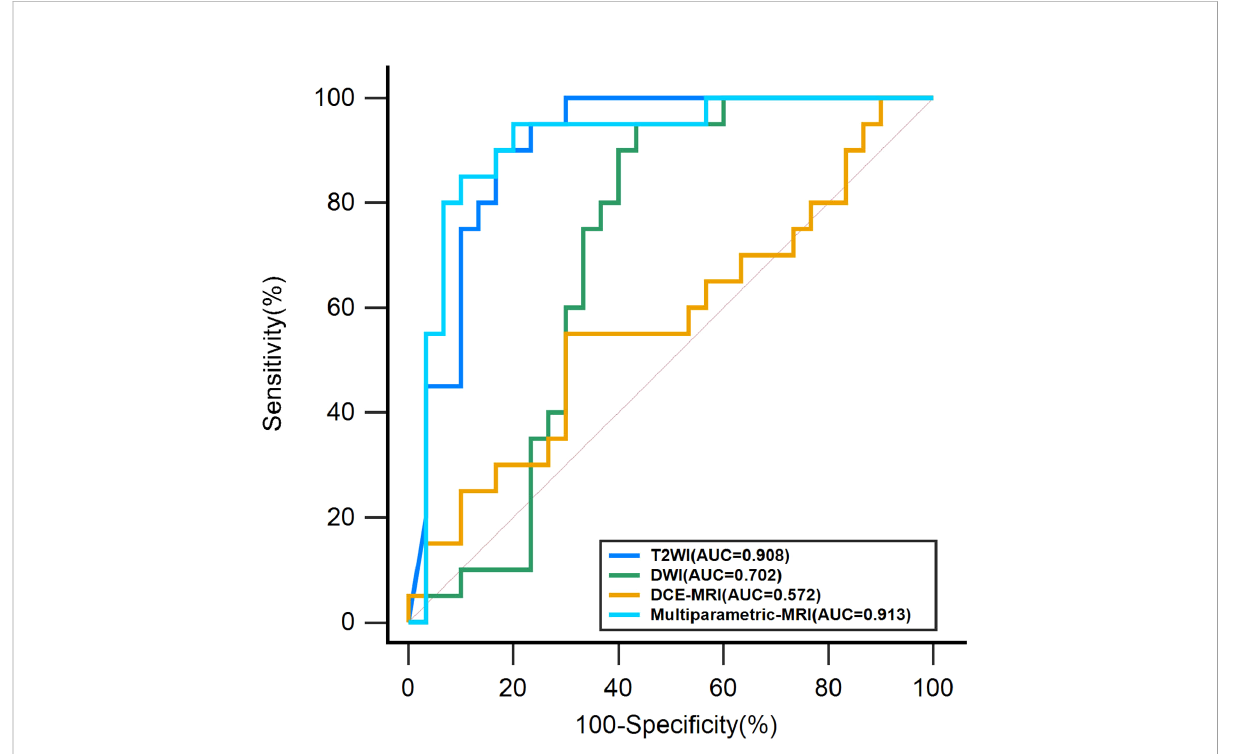
FIGURE 5 The Roc curves of the base and multiparametric MRI